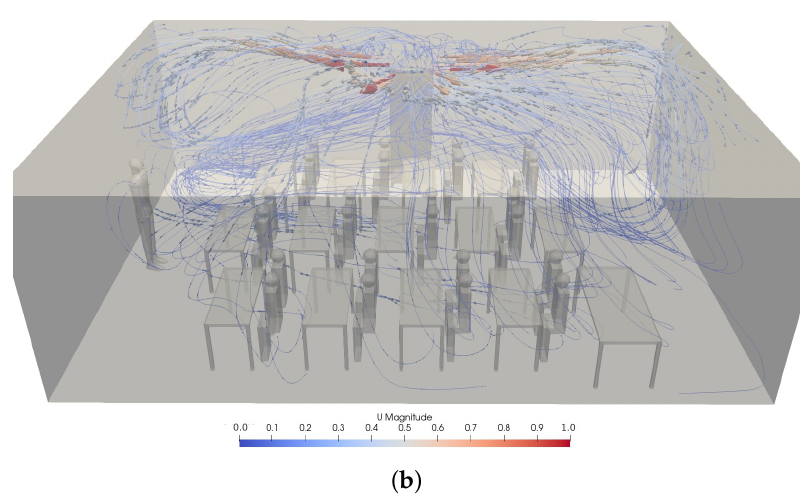
Figure 5. A snapshot of the flow field in the classroom for the two configurations: ( a ) AP on the short side of the room. ( b ) AP on the long side of the room. The colour of the streamlines and velocity vectors represents the magnitude of